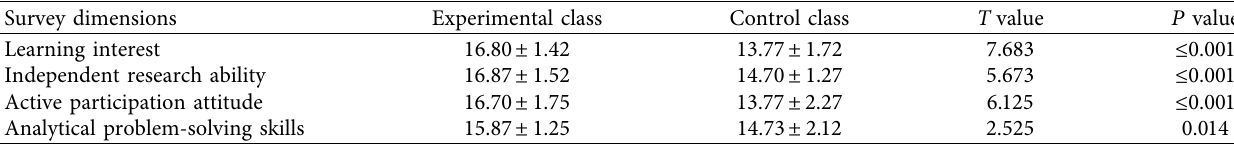
Table 4: Test of students’ martial arts learning situation in the two classes after the